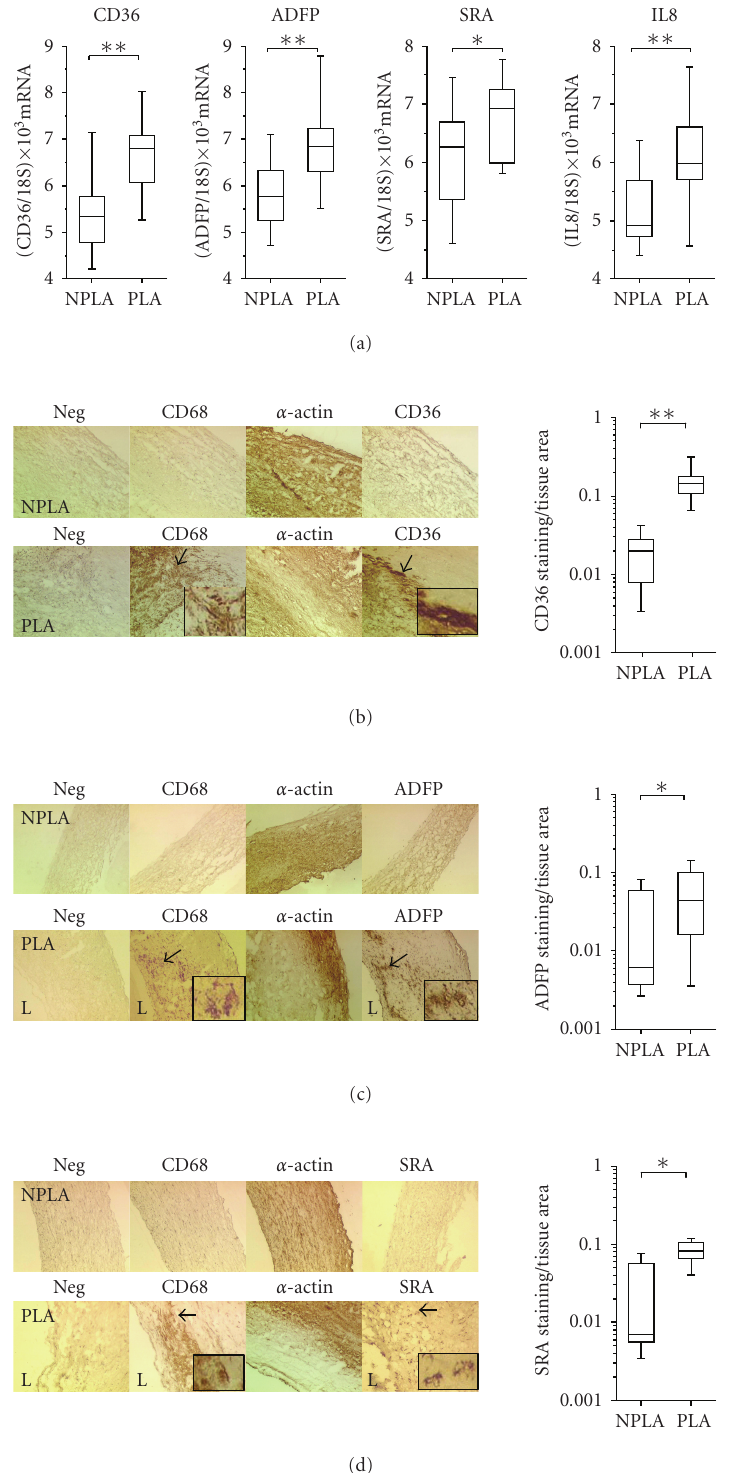
Figure 3: Gene and protein expression levels in carotid endarterectomy PLAs (plaque lesion areas) and NPLAs (nonplaque lesion areas). (a) Real-time quantitative PCR showing gene expression levels for CD36, adipophilin (ADFP), SRA, and IL-8 in carotid endarterectomy PLA compared to NPLA. (b) Staining of negative isotype, CD68, α -actin, and CD36 proteins in PLA and NPLA and quantitative immunohistochemistry for CD36 protein expression in PLA versus NPLA. (c) Staining of negative isotype, CD68, α -actin, and ADFP proteins in PLA and NPLA and quantitative immunohistochemistry for ADFP protein expression in PLA versus NPLA. (d) Staining of negative isotype, CD68, α -actin, and SRA proteins in PLA and NPLA and quantitative immunohistochemistry for SRA protein expression in PLA versus NPLA. Wilcoxon matched pairs test was used to determine significance. ∗∗ P ≤ . 001, ∗ P ≤ . 05; L: lumen; magnification: